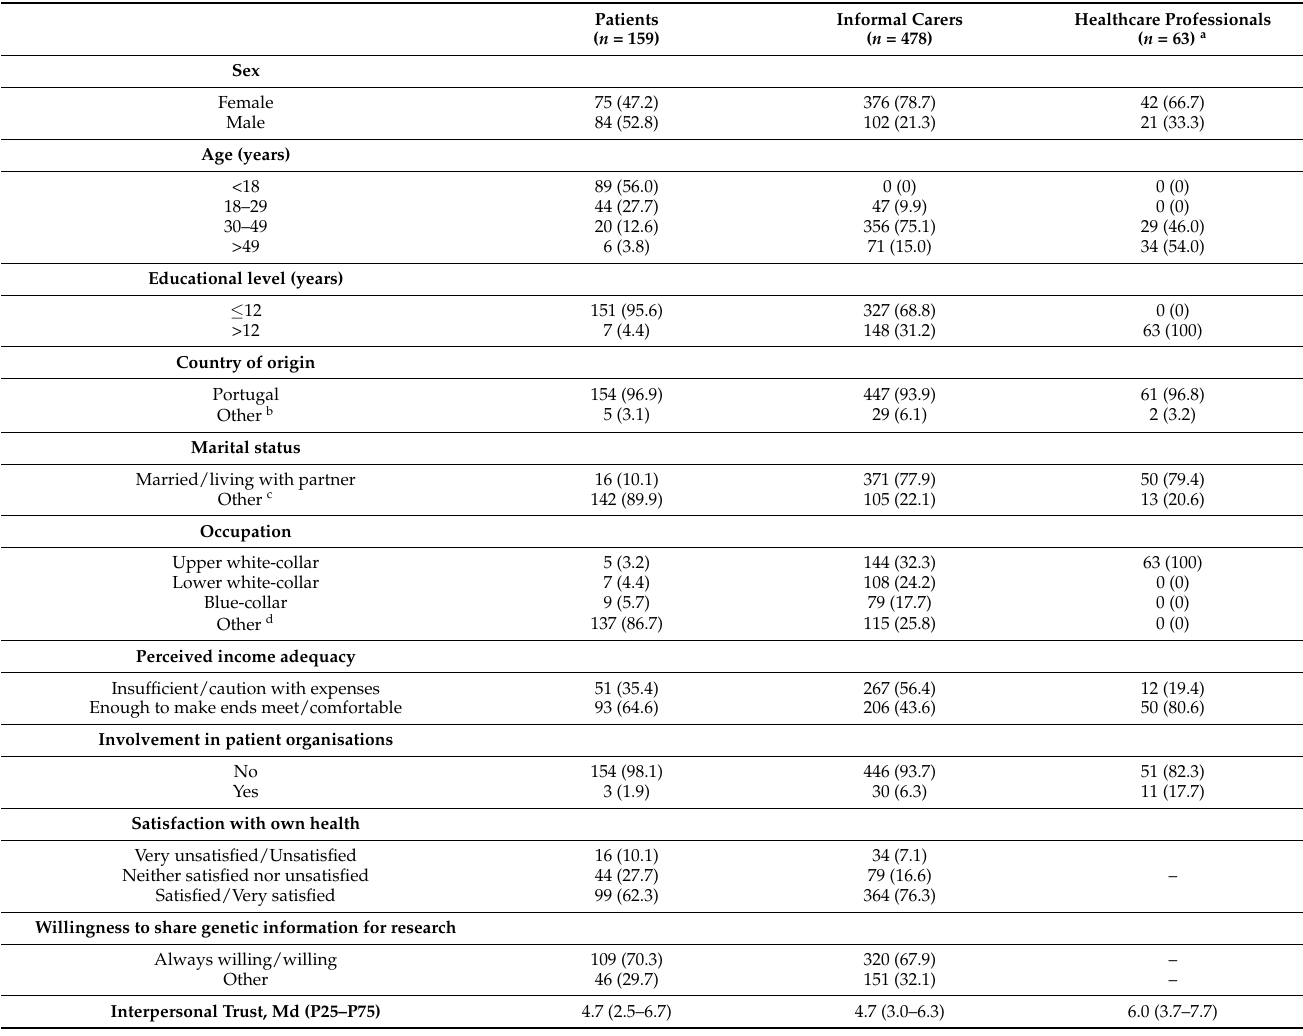
Table 1. Participants’ characteristics and willingness to share genetic information for